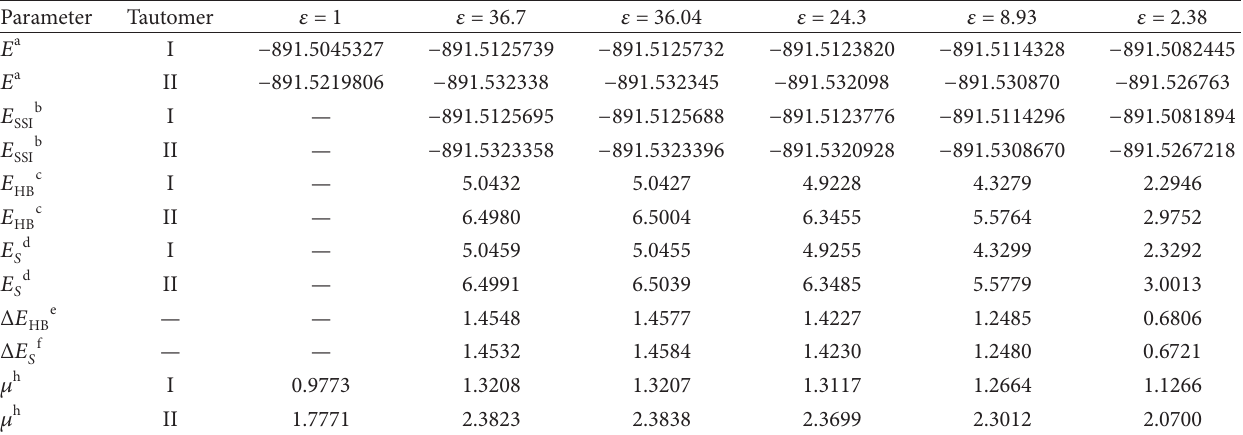
T 3: Calculated energies and dipole moments at the B3LYP level with 6-311++G